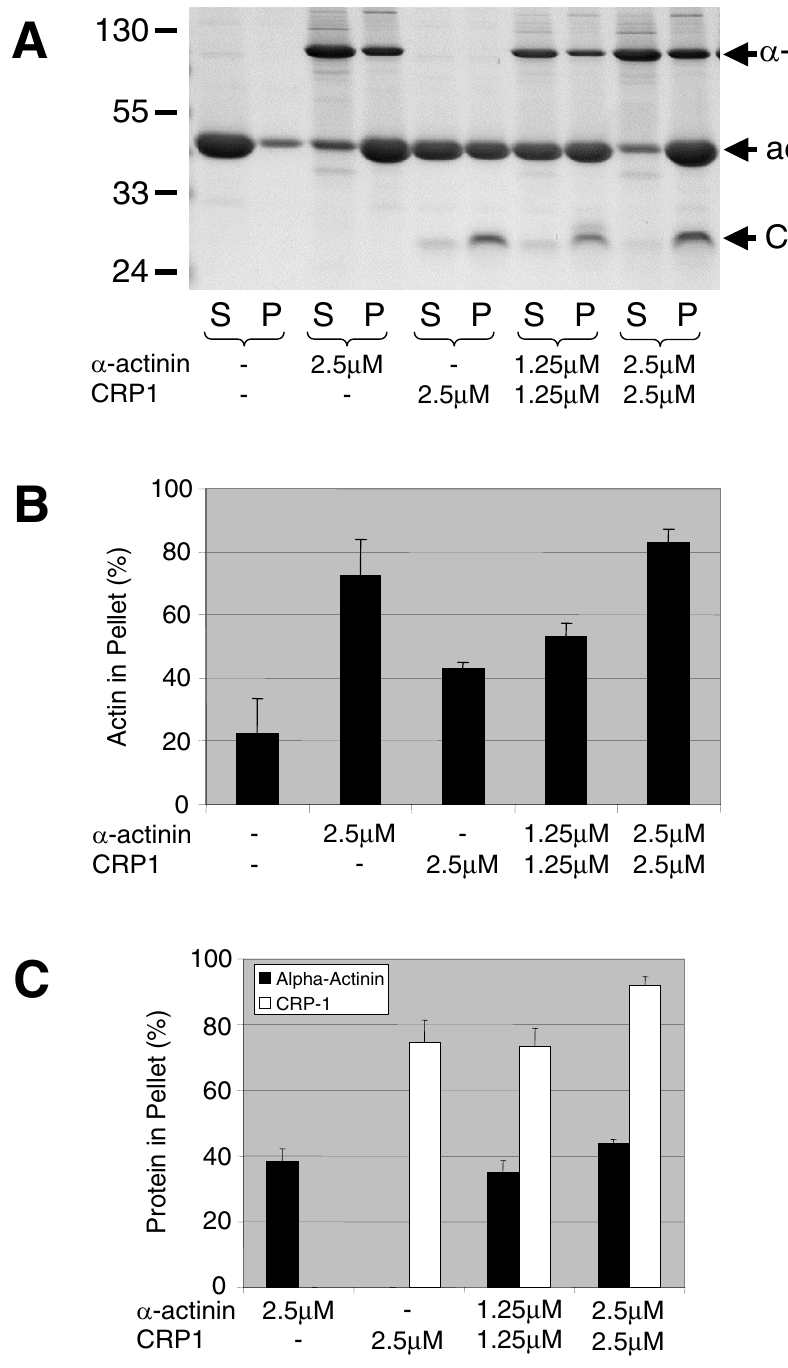
Figure 2 CRP1 does not influence the bundling activity of α -actinin . α -Actinin and CRP1 were preincubated for 15 min at room temperature. Actin filaments were then added, incubated for 30 min at room temperature, and centrifuged at 10,000 × g. Pro- teins from the supernatant (S) and the pellet (P) were separated by electrophoresis and detected by Gelcode Blue staining ( A ). The percentage of total actin ( B ) and α -actinin and CRP1 ( C ) in the pellet was quantified as described in Experimental Proce- dures. n = 4 ±